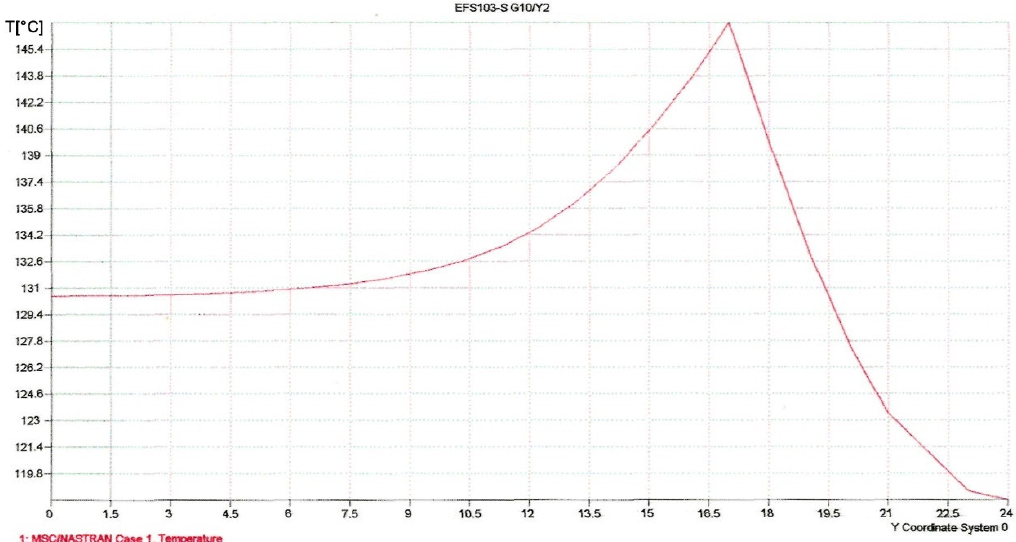
Figure 12. Thermal loading of the rings for EFS 103−S, G10/Y2, along the interface.